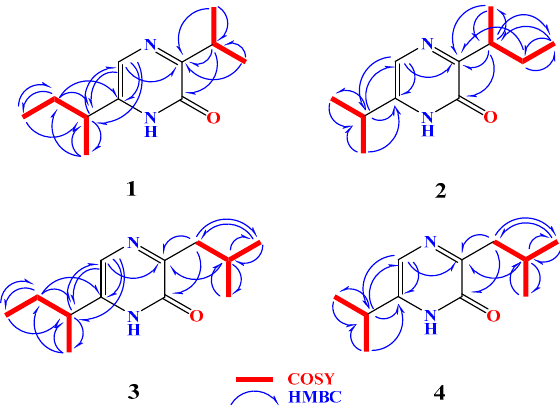
Figure 2. Key COSY and HMBC correlations of 1 – 4 .